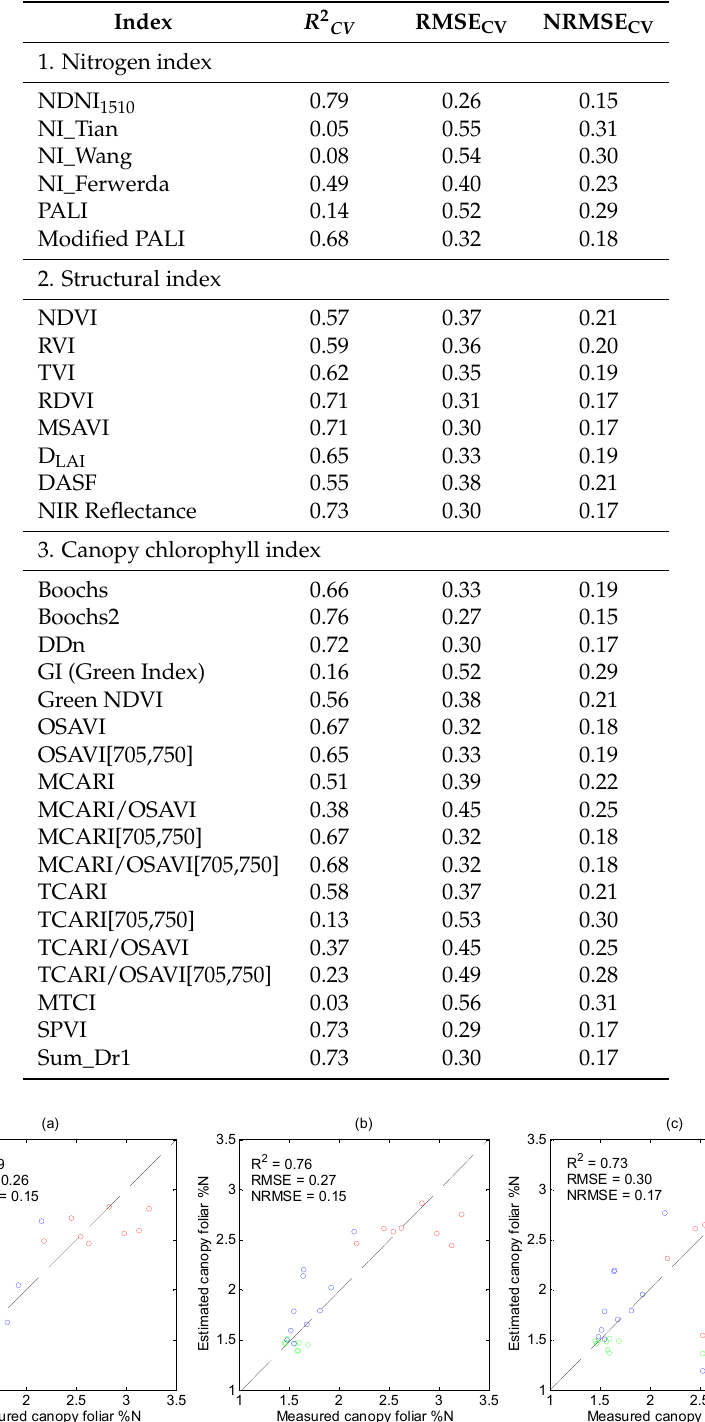
Table 4. The performance of spectral vegetation indices for estimating canopy foliar %N.